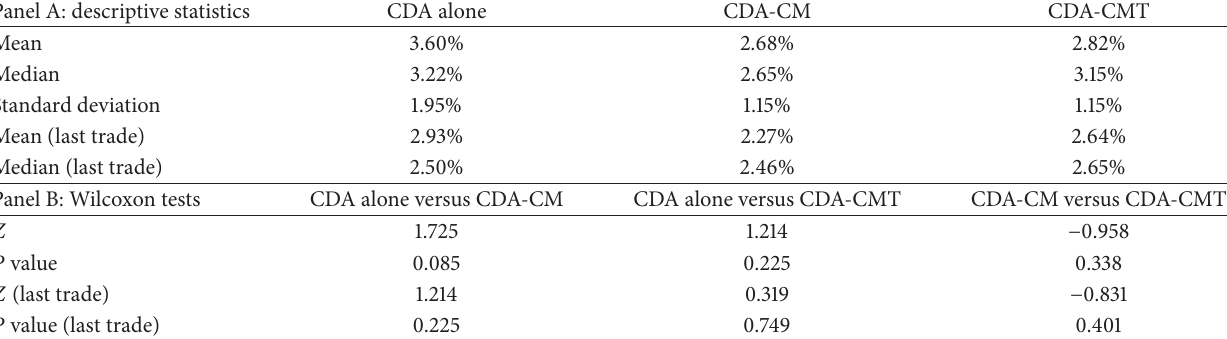
Table 3: Descriptive statistics of period and last trade MRE CDA values as well as results of Wilcoxon rank sum tests between the stand-alone CDA and the CDA of the complement markets.